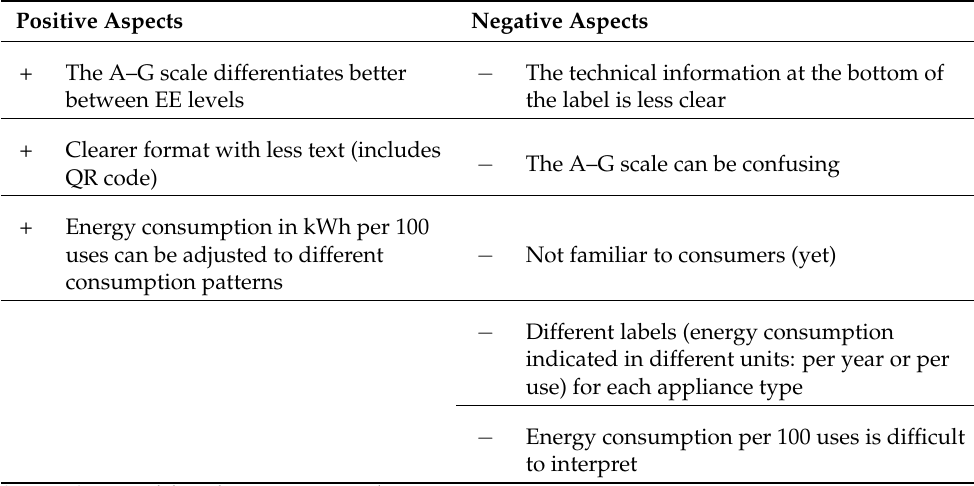
Table 2. Comparison of the new and old EE labels based on the opinions of the public, retailers and